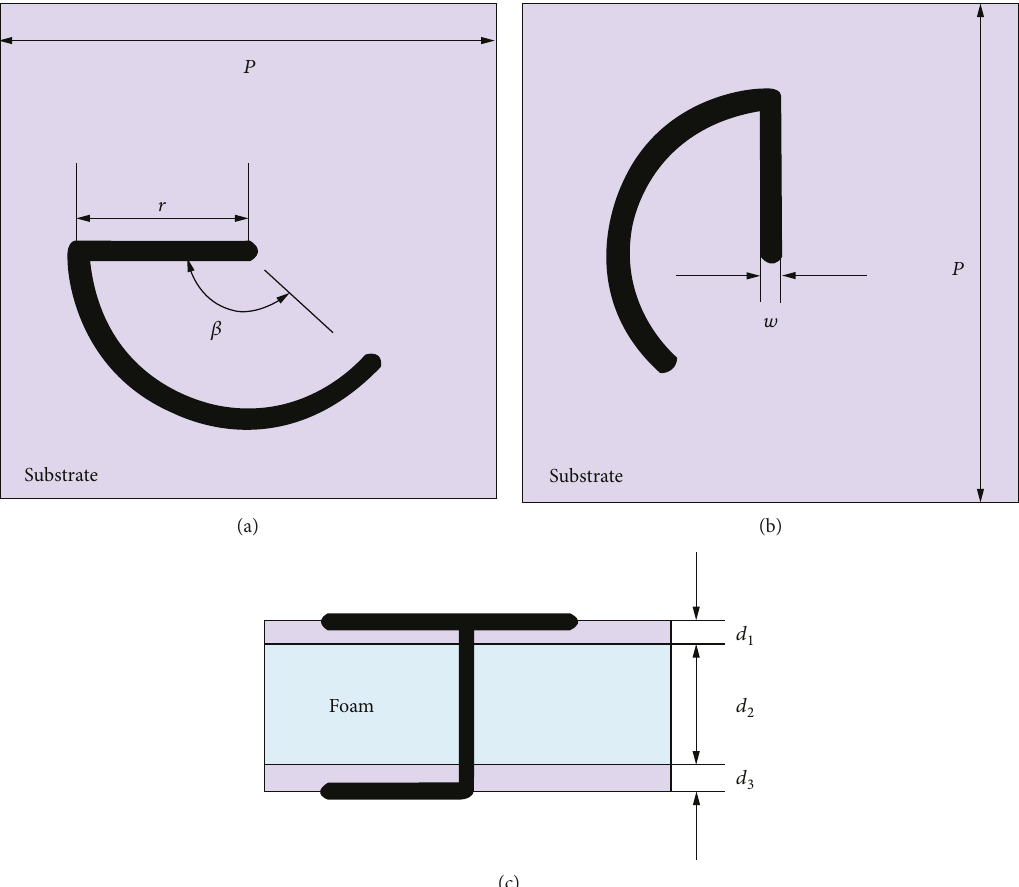
Figure 2: Geometry of the proposed dual-mode CPSS cell: (a) top view, (b) bottom view, and (c) side